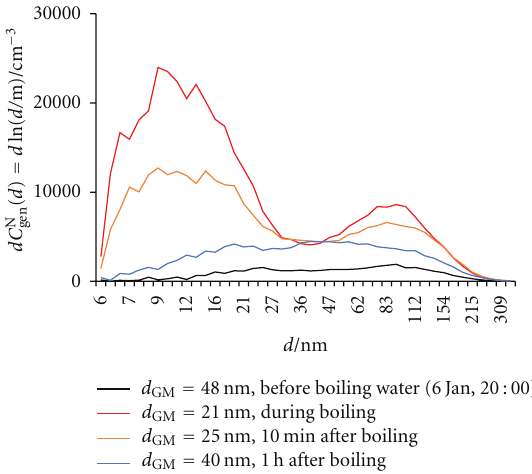
Figure 21: Number size distributions (d C N ( d ) = dln( d/ m)) of general aerosol particles in indoor air before, during, and after boiling water. gen